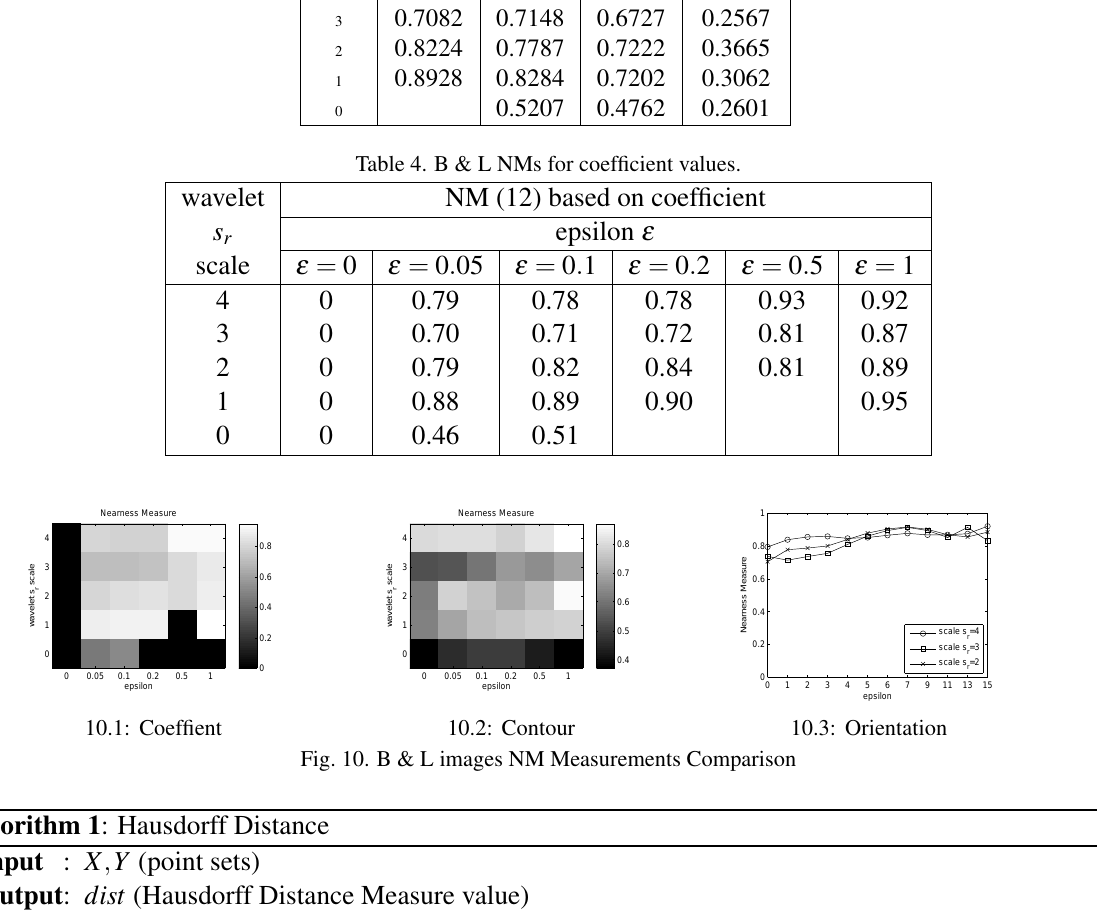
Algorithm 1 : Hausdorff